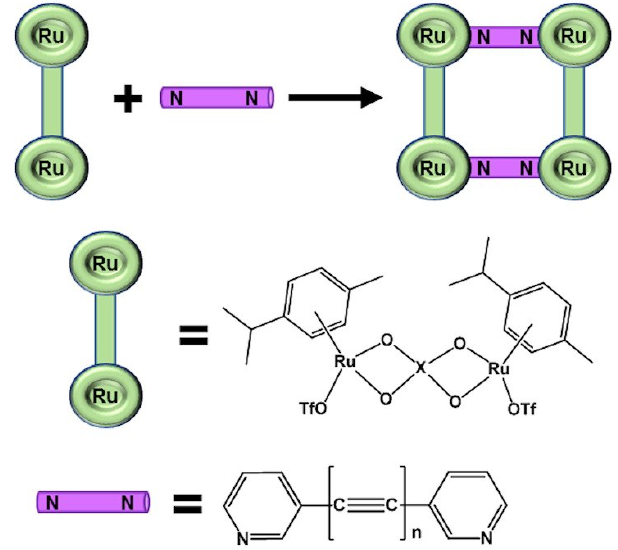
Figure 22. Self-assembly of tetranuclear molecular rectangles.